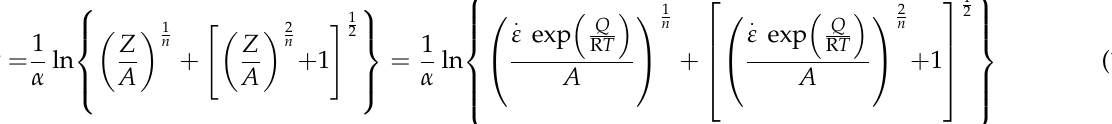
Table 5. Coefficients of the polynomial for α , n , Q and ln A.